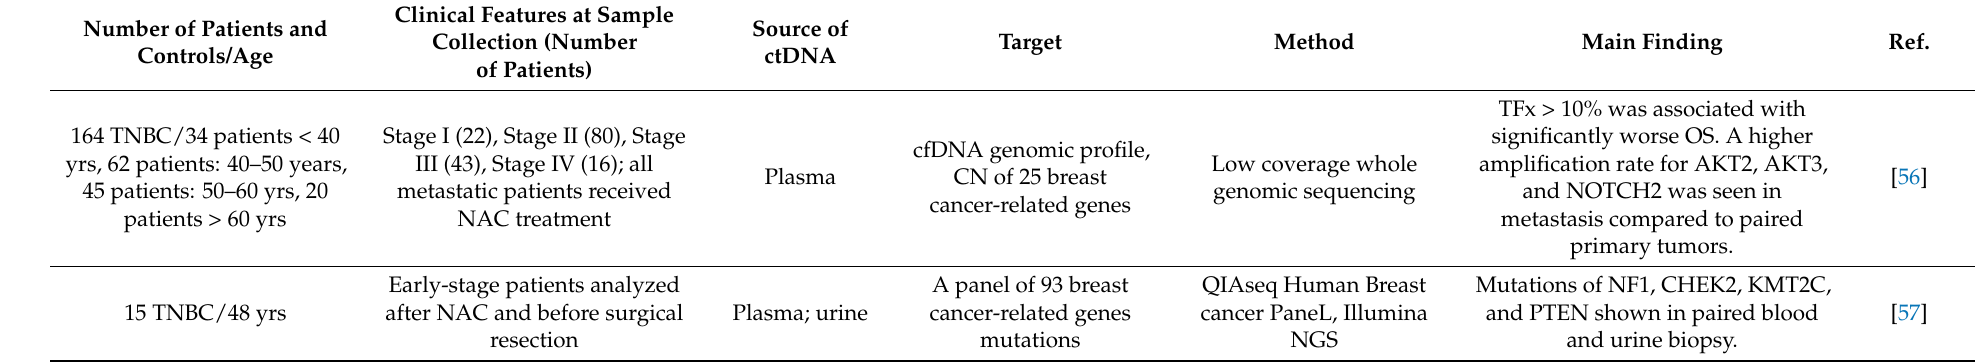
Table 2. Summary of TNBC clinical features, experimental method, and main results in liquid biopsy on ctRNA. Abbreviations: BBD (benign breast